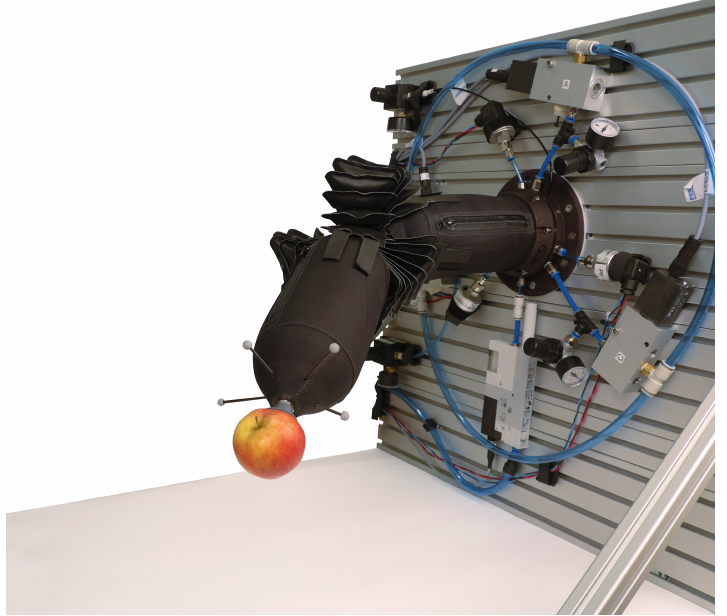
Figure 1. The inflatable soft robotic arm presented in this work shown manipulating an apple. The system is made of fabric and uses three bellow-type actuators to control its two rotational degrees of freedom and adjust its joint